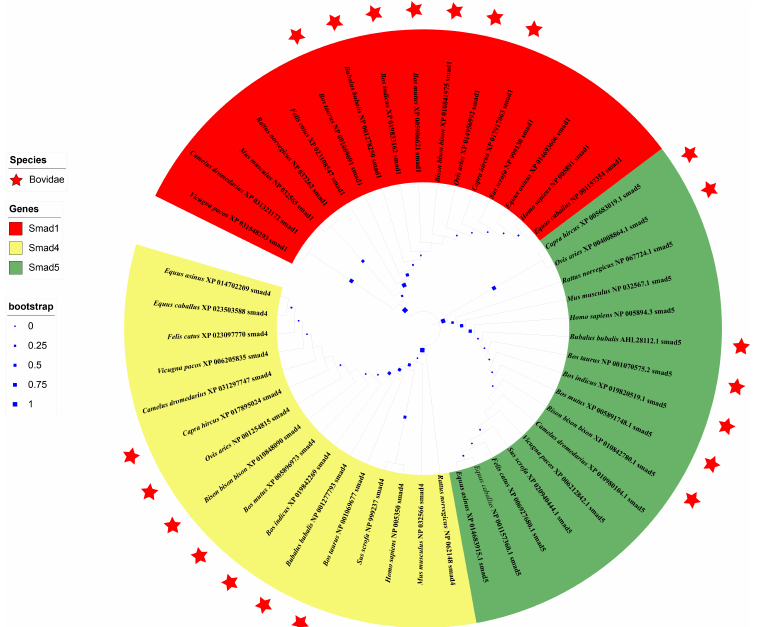
Figure 5. Phylogenetic trees constructed based on the AASs of Smads 1 , 4 , and 5 in buffalo and other mammals. The bootstrap values of each branch in the tree were labelled with blue boxes of different sizes. The species in the family of Bovidae were labelled by a red